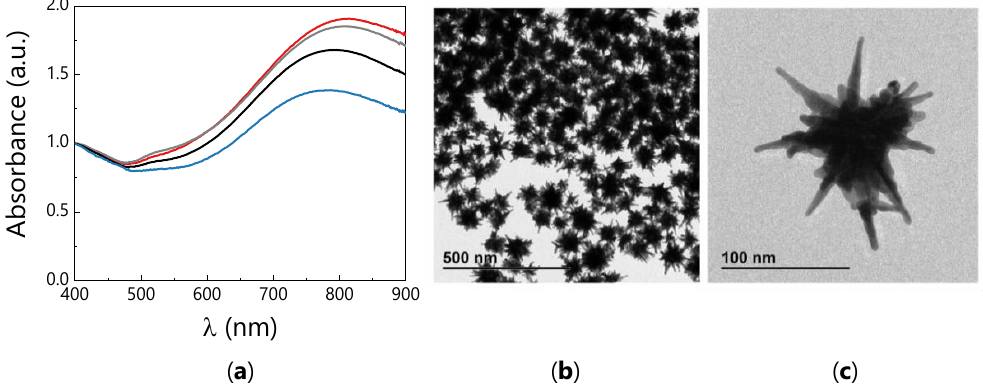
Figure 1. ( a ) Normalized UV-Vis-NIR spectra of the AuNSs with LSPR bands centered at 812 nm in water (red line) and 805 nm in HEPES-buffered medium (gray line), and of the liposome-AuNS and lipoplex-AuNS systems with the LSPR band centered at 785 (black line) and 780 nm (blue line) and ( b , c ) TEM micrographs of AuNSs at low and high magnifications.